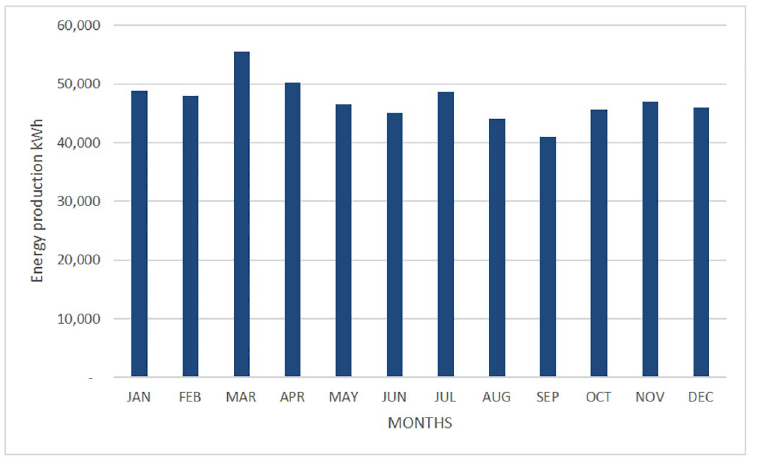
Fig 2. Monthly energy generated by the PV system in Morelia